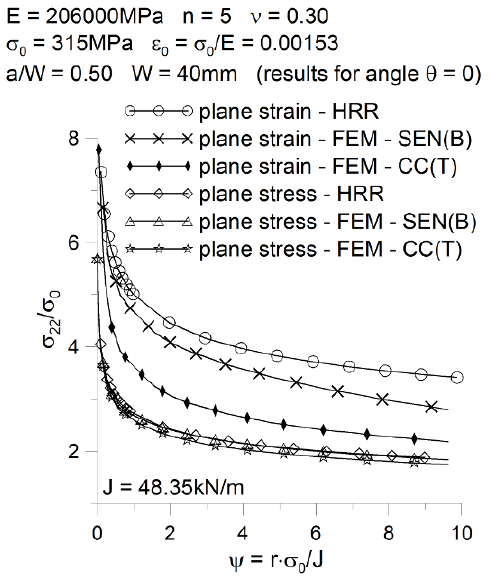
Figure 2. Comparison the FEM results and HRR solution for plane stress and plane strain for single edge notched specimen in bending (SEN(B)) and centre cracked plate in tension